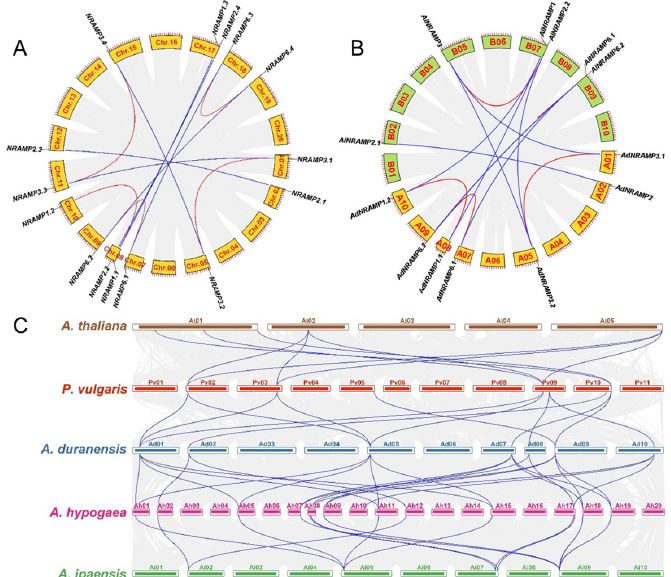
Figure 3. Synteny relationship of NRAMP gene pairs in peanut and other four species. ( A ) Synteny relationship of AhNRAMP gene pairs in peanut. ( B ) Synteny relationship of NRAMP gene pairs between A. duranensis and A. ipaensis . ( C ) Synteny relationship of NRAMP gene pairs among five plant species. The red and blue lines represent segmental duplicated genes and synteny genes, respectively. The gray lines show the collinear blocks of the plant